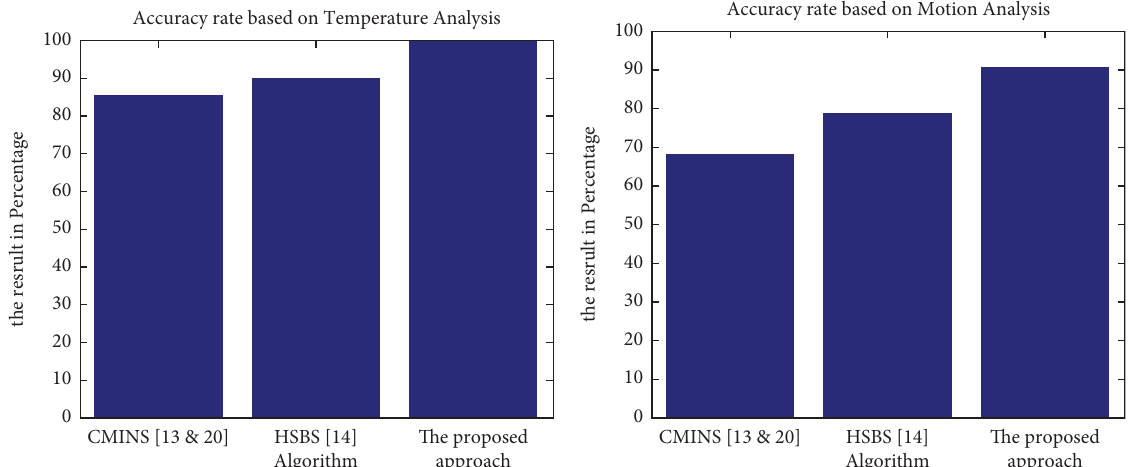
Figure 22: Te comparison between the two previous algorithms and the proposed